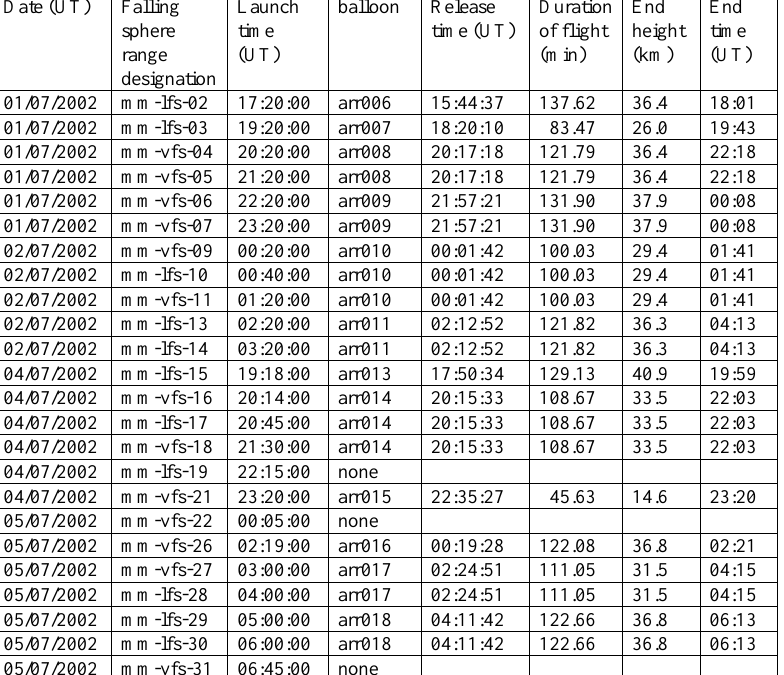
Table 3. Falling sphere and balloon information for Figs. 7 and 8. MIDAS/MaCWAVE Campaign July 2002, Andøya,